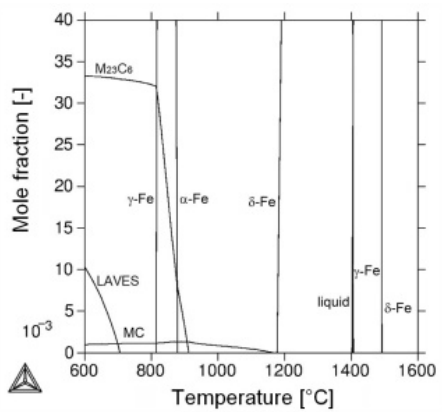
Figure 14. Calculated temperature dependence of mole fractions of equilibrium phases for investigated P92 steel.